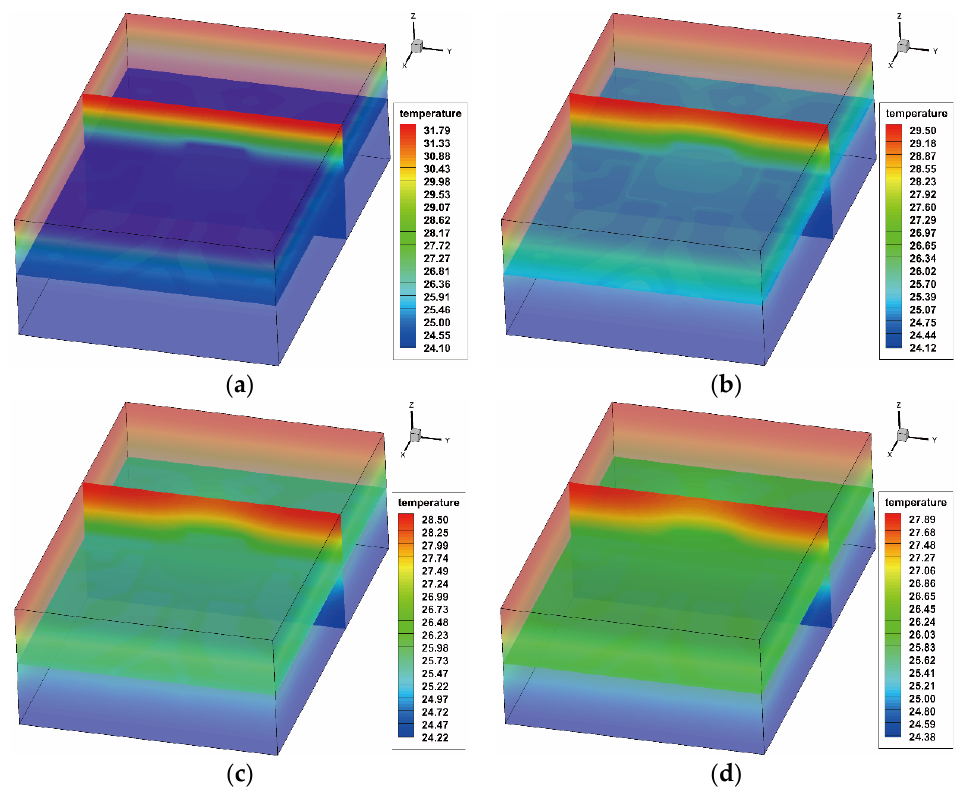
Figure 7. Temperature distribution after the flash; ( a ) 0.04s after the flash; ( b ) 0.08s after the flash; ( c ) 0.12s after the flash; ( d ) 0.16s after the flash. ( c ) 0.12 s after the flash; ( d ) 0.16 s after the flash.